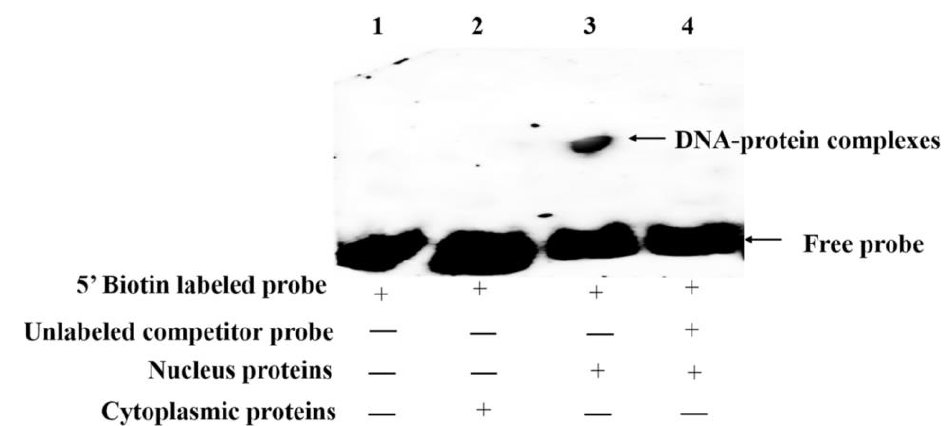
Figure 5. Electrophoretic mobility shift assay (EMSA) of the common carp acsl6 core promoter with muscular nuclear proteins: Each lane is represented as lane 1 (no proteins, 5′ biotin labeled probe), lane 2 (muscular cytoplasmic protein and 5′ biotin labeled free probe), lane 3 (muscular nucleoprotein and 5′ biotin labeled free probe), and lane 4 (muscular nucleoprotein, unlabeled competitor probe, and 5′ biotin labeled free probe). “+” means that the corresponding material in the row has been added, and “−” means that the material is not added.